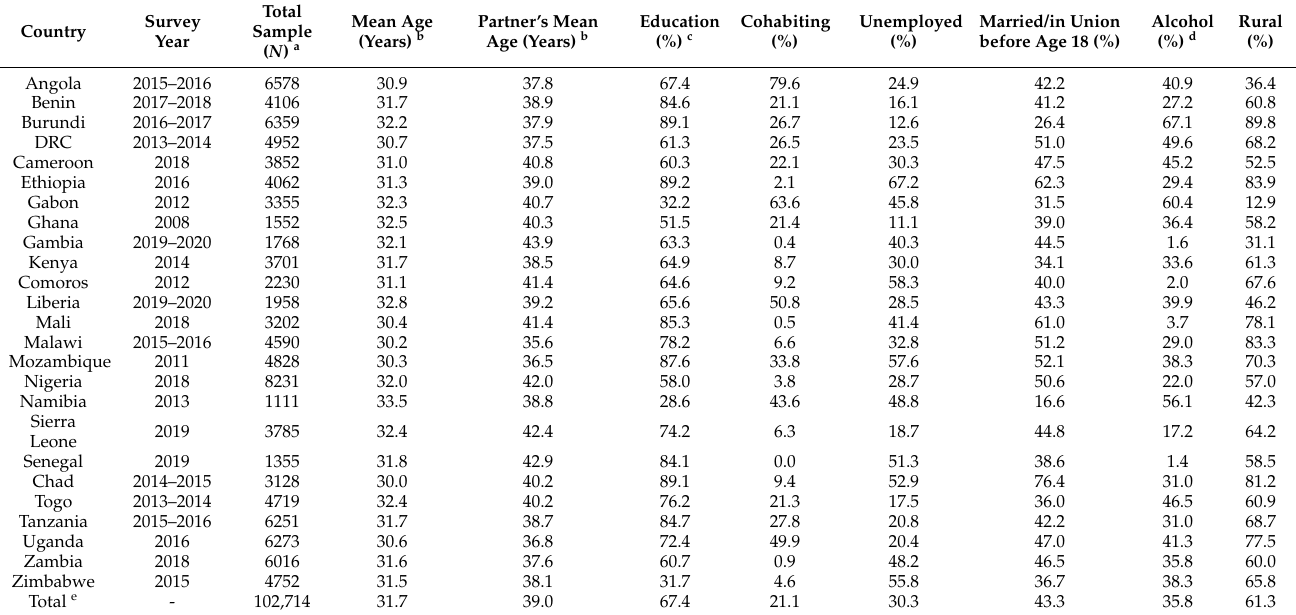
Table 1. Demographic characteristics of the study